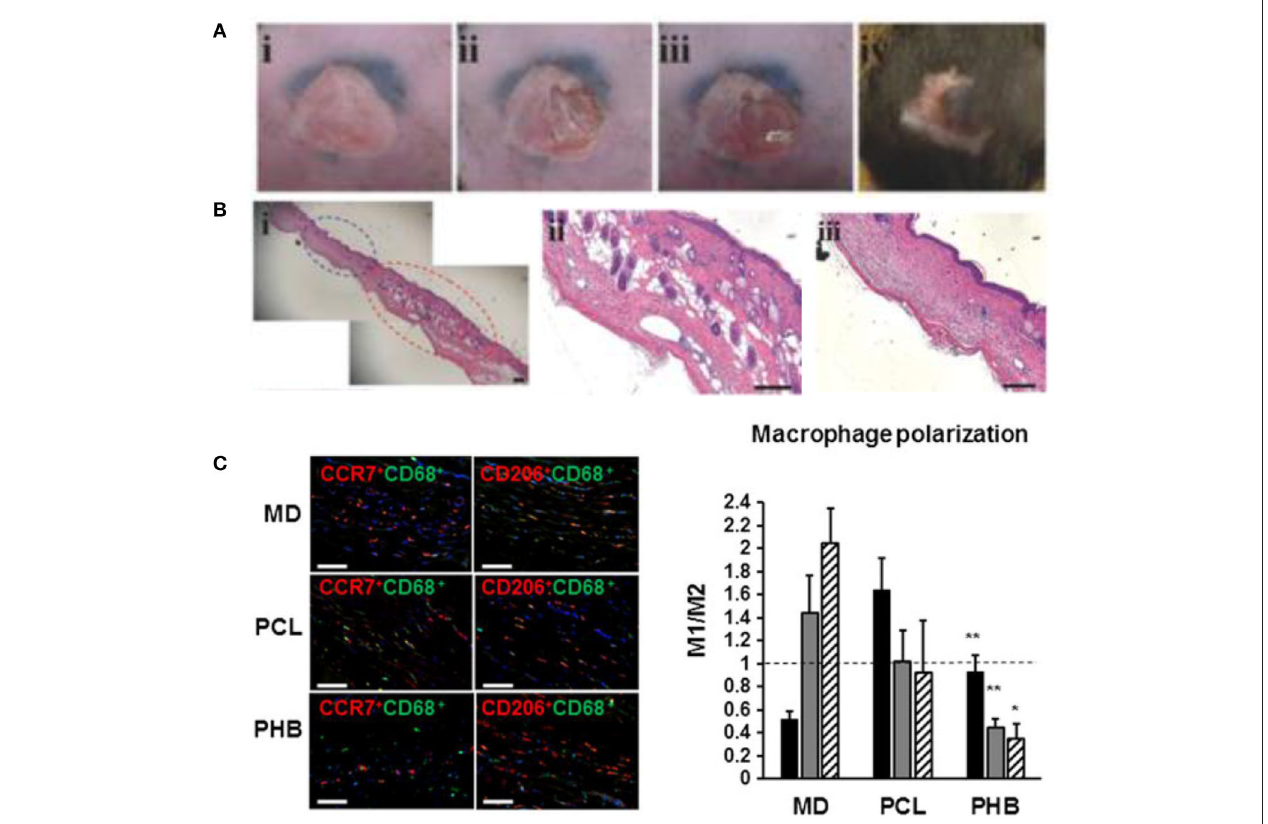
FIGURE 6 | Immunomodulating biomaterials are effective in wound healing applications. (A) Creation of scar and treatment with immunomodulating DexIEME hydrogel. (i) Scar created by third degree burn, (ii) partial excision of scarred skin, (iii) apply hydrogel, (iv) wound healed after 5 weeks. (B) (i) H&E Stained scarred and regenerated skin, (ii) regenerated skin shows development of hair follicles, (iii) scarred skin lacking normal skin structure. Scale bars = 200 µ m. Reprinted with permission from Sun (2017). Copyright 2017, John Wiley & Sons. (C) Macrophage polarization employed by treatment with Matriderm ® (MD), PCL scaffolds, and PHB electrospun scaffolds. Nuclei were stained with DAPI (blue). M1(CCR7 + CD68 + )/M2(CD206 + CD68 + ) ratio of macrophages present in the scaffold surrounding region 14 days following implantation. Scale bars = 50 µ m (* p < 0.05, ** p < 0.01). Reprinted with permission from Castellano et al. (2018). Copyright 2018, John Wiley &